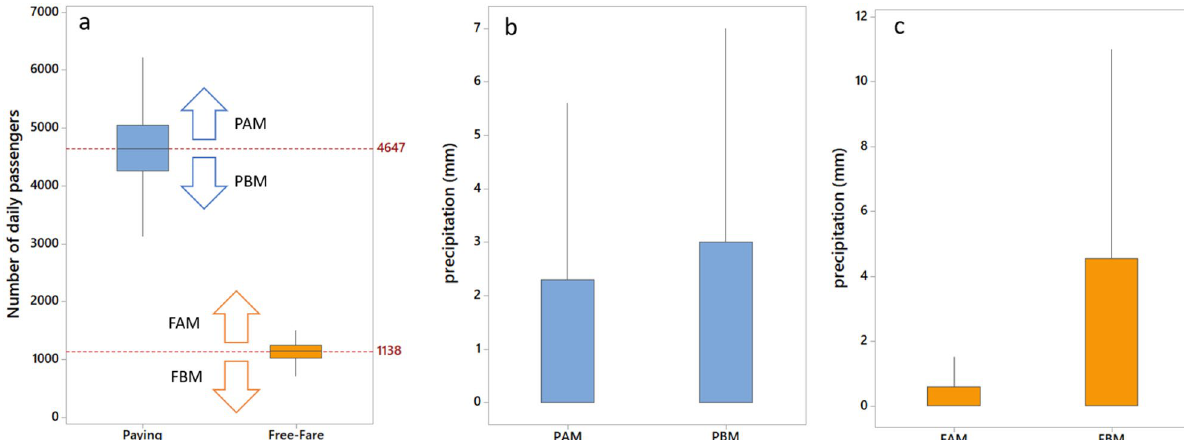
Figure 3. Boxplot of the number of daily paying and free-fare passengers for bus line 1742-10. Each group was split into sub-groups below and above the median line ( a ). The precipitation is not significantly visually different for paying above median line (PAM) and paying below median line (PBM) passengers ( b ), but there is a significant difference between free-fare above median line (FAM) and free-fare below median line (FBM) passengers ( c